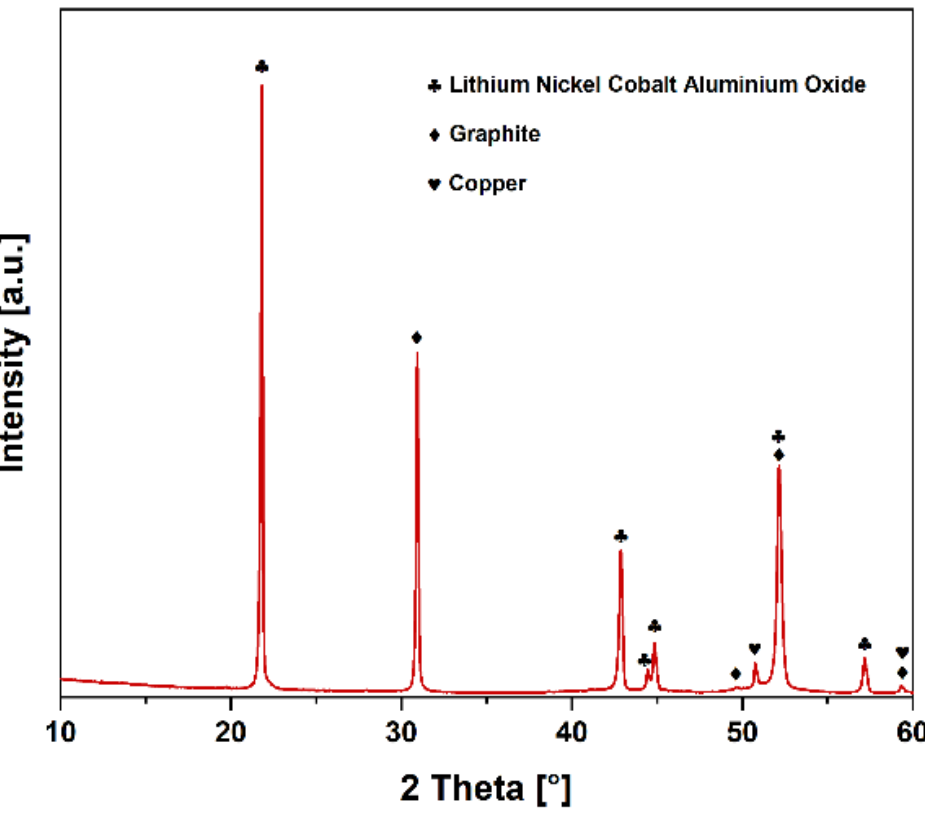
Figure 6. PXRD pattern of NCA black matter after EHF processing and flotation.